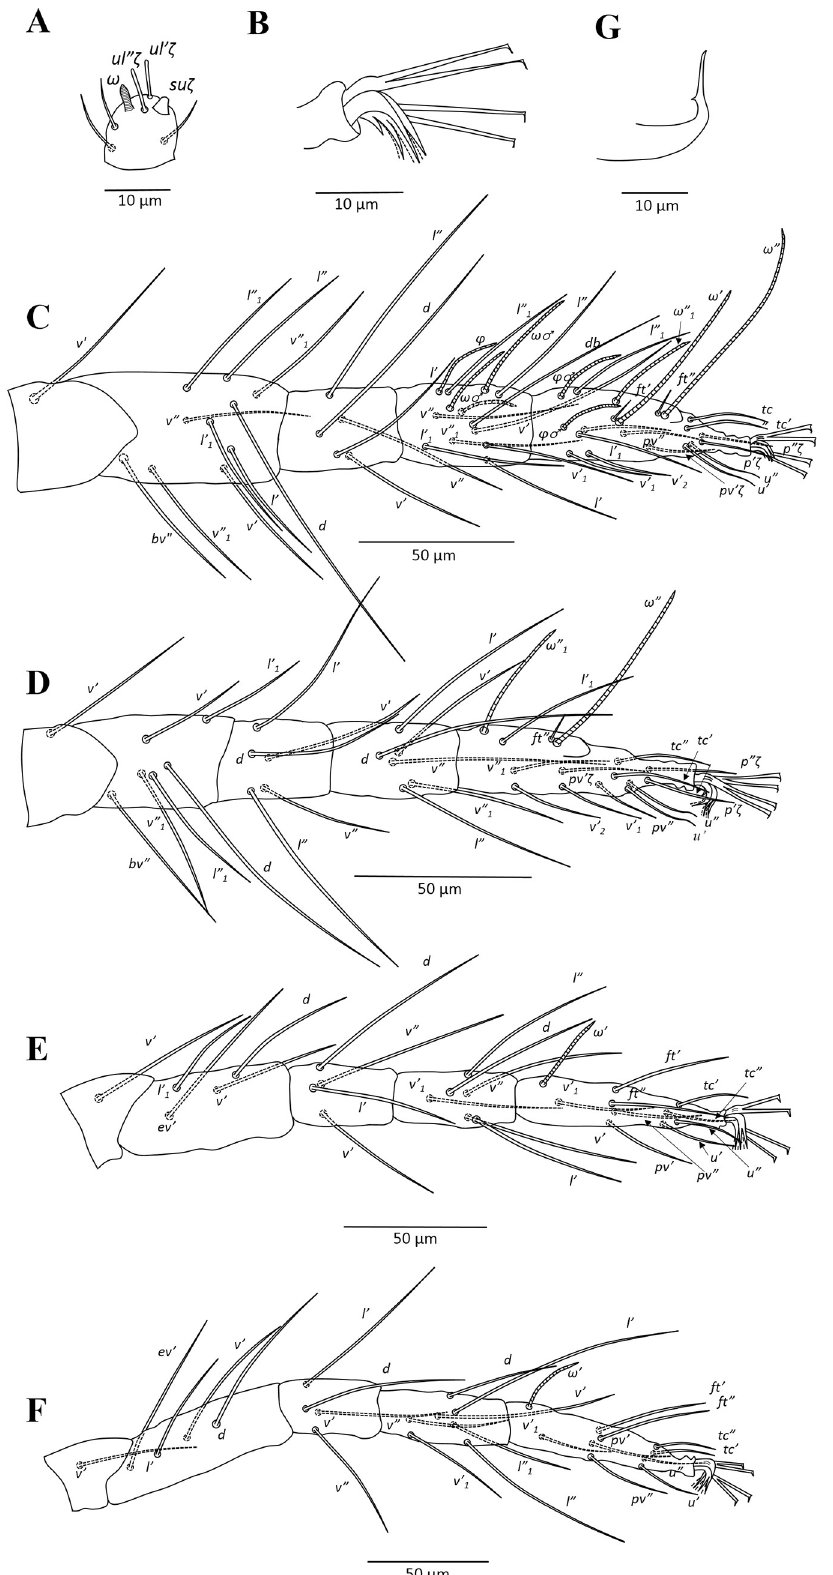
Fig 9. Amphitetranychus viennensis , male—A. Distal segment of palpus, B. Empodium of leg I, C. Leg I, D. Leg II, E. Leg III, F. Leg IV, G. Aedeagus. https://doi.org/10.1371/journal.pone.0221951.g009 PLOS ONE | https://doi.org/10.1371/journal.pone.0221951 September 13,